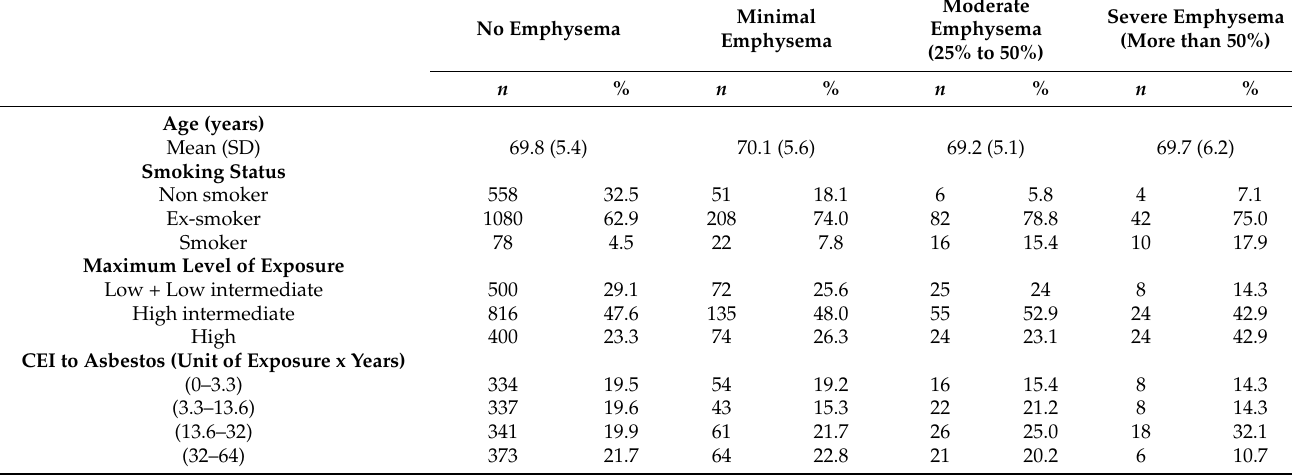
Table 4. Frequency of emphysema at CT according to age, smoking status and asbestos exposure